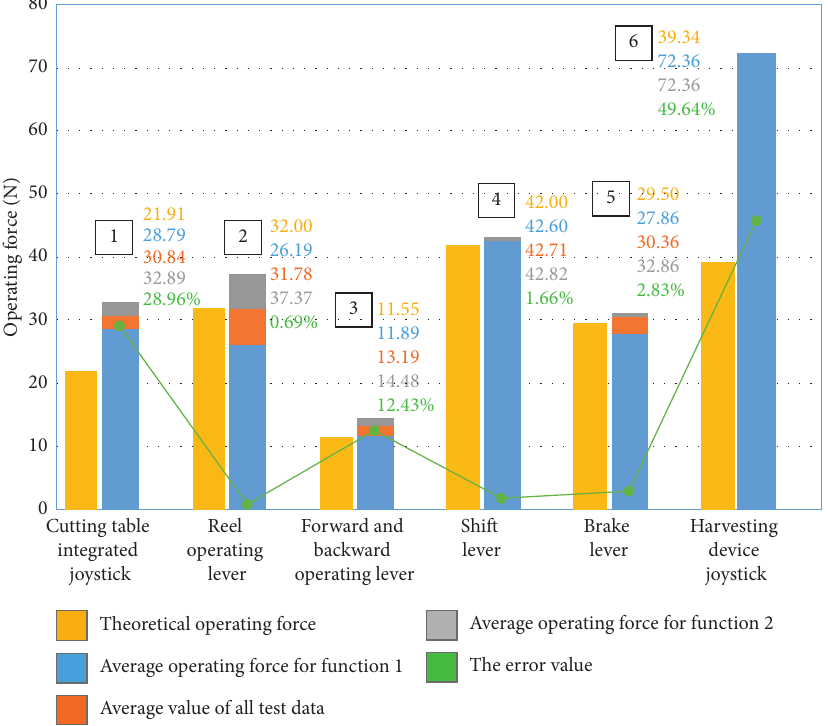
Figure 17: Comparison between theoretical operating force and actual operating force.